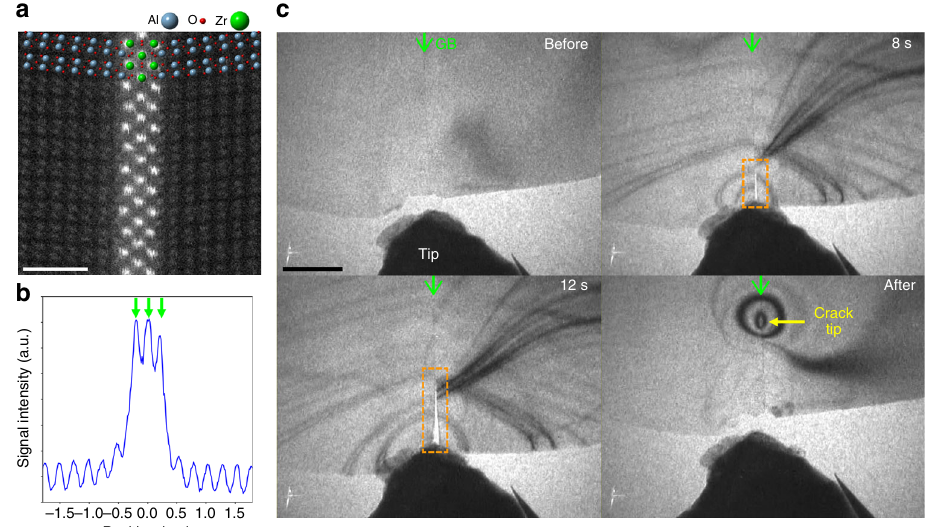
Fig. 1 HAADF-STEM image of the Zr-doped Σ 13 grain boundary and sequential TEM nanoindentation images of interfacial crack propagation. a HAADF- STEM image of the Zr-doped Σ 13 grain boundary in alumina observed from the h 2110 i directions. Zr atoms (strong intensity columns) are segregated in the triple layer at the grain boundary core. The calculated structural model is superimposed on the image, where Al, O, and Zr atoms represent as blue, red, and green colour, respectively. b Intensity pro fi le of the HAADF-STEM image across the grain boundary. The signal is averaged along the vertical direction to reduce the scanning noise. Three large peaks indicated by the green arrows correspond to the triple Zr layer positions. c Sequential TEM images during the TEM nanoindentation experiment. The TEM movie during the nanoindentation is available in Supplementary Movie 1. The indicated times in each image represent the elapsed time after contacting the indenter tip with the specimen edge. The green arrows in each image indicate the position of grain boundary (GB), and the dashed rectangles indicate the grain boundary crack. The yellow arrow in the bottom-right image indicates the crack tip position after nanoindentation. The scale bars in a and c are 1 and 200 nm, image of the crack tip area. In the upper part of the image (blue rectangle), the Zr atoms form the triple layer structure similar to the initial (unfractured) grain boundary structure. Going down to the middle of the image (yellow rectangle), the contrasts of the Zr columns gradually become ambiguous, and the grain boundary starts to be cleaved into the two surfaces. In the lower part (red rectangle), the Zr columns seem to form a four-layered structure. This indicates that the triple layer structure was cleaved into two layers on each fracture surface. Thus, the fracture path proceeded within the centre layer of the triple Zr layer of the initial grain boundary core, and the Zr atoms at the centre layer column are separated and attached on both fracture surfaces of the two crystals.